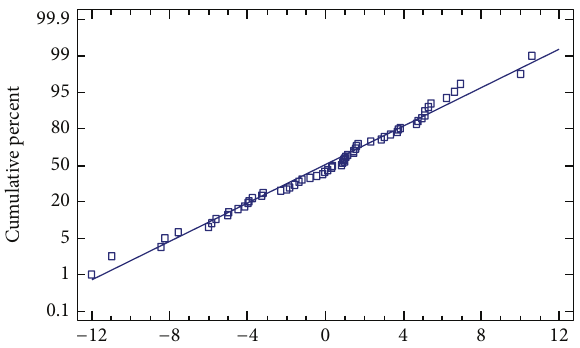
Figure 5: Normal probability plot of ANOVA residuals.